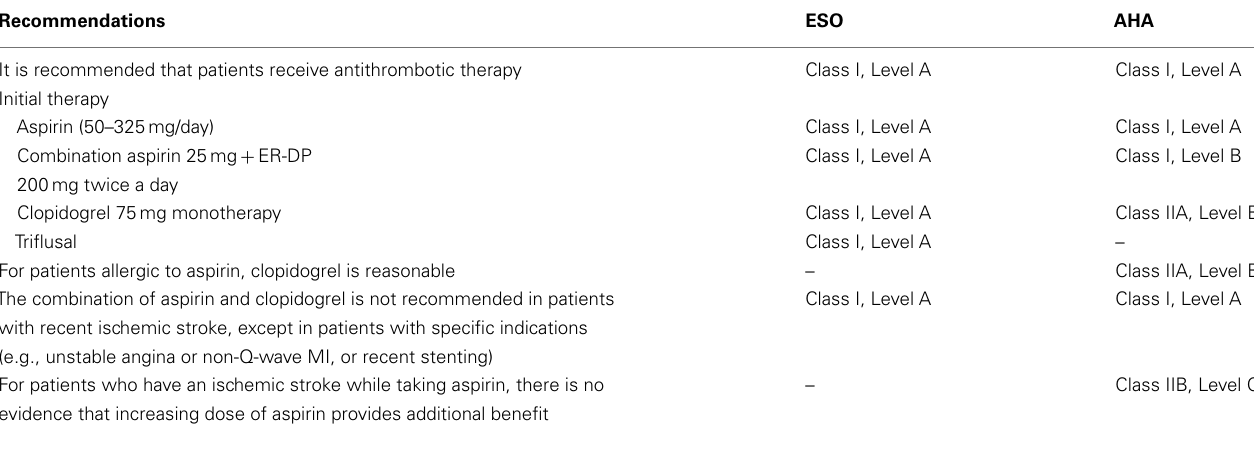
Table 1 | Recommendations for antiplatelet therapy in secondary stroke prevention for non-cardioembolic ischemic stroke orTIA.